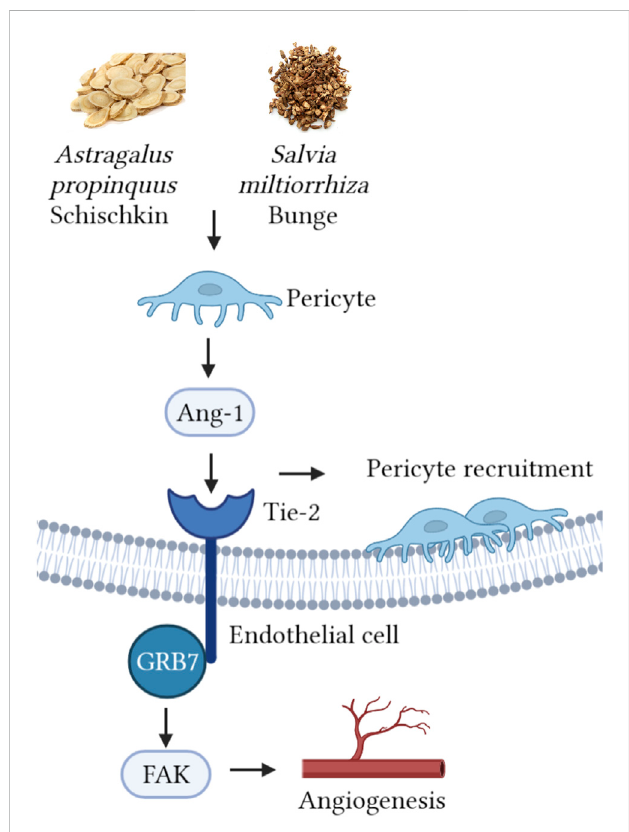
FIGURE 5 Astragalus propinquus Schischkin and Salvia miltiorrhiza Bunge regulate pericyte recruitment and promote angiogenesis to treat MI via Ang-1/Tie-2/FAk